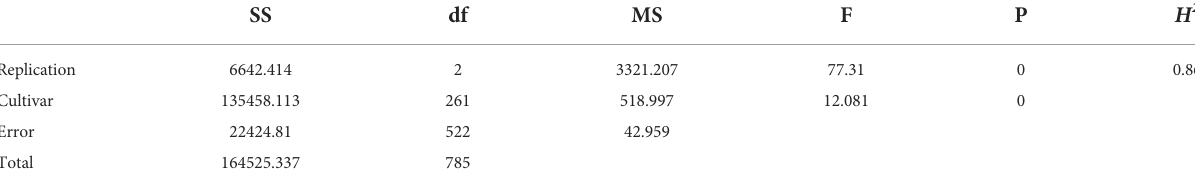
TABLE 2 The ANOVA of wheat sharp eyespot disease scores of the cultivars.